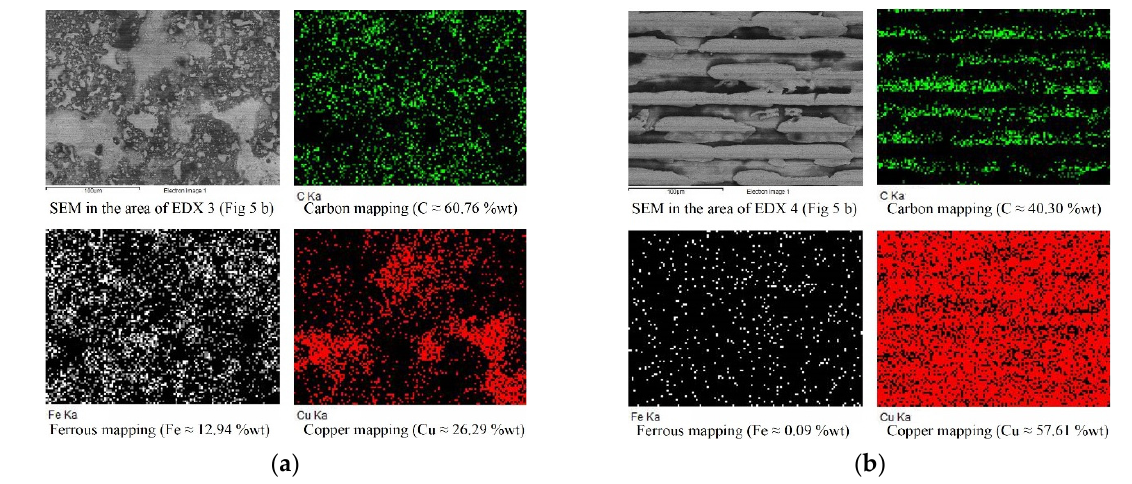
Figure 13. Analysis of alloy element mapping on the step cylindrical electrode (SCE). ( a ) Elemental mapping in the area of EDX 3; ( b ) elemental mapping in the area of EDX 4.